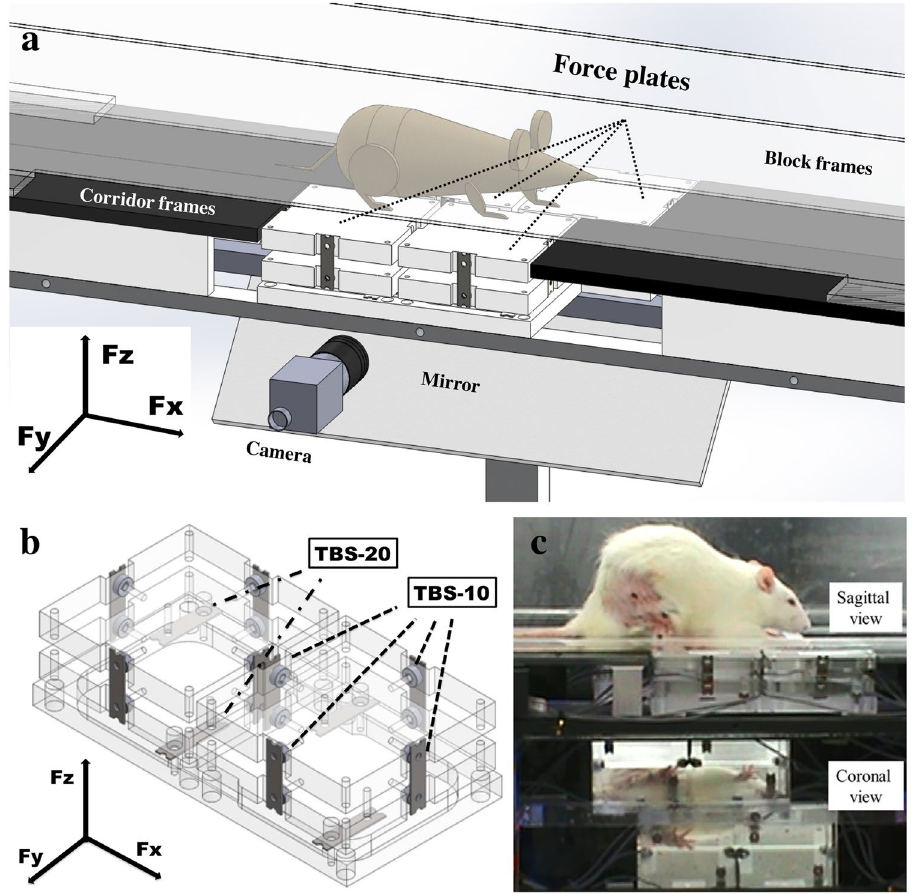
Figure 5. The system consisted of four force-sensor units, four corridor frames (black acrylic plates), two transparent block frames, a 45° mirror, and a CCD digital camera with the GigE interface. The force-sensor units could be easily placed in the corridor frames in combination for various tasks (usually in the center of the corridor). The two transparent block frames were adjustable to guide the rats to make a straight walk ( a ). Every force-sensor unit was composed of two acrylic plates mounted with four TBS-10 beam force sensors to measure Fx and Fy, and one steel frame mounted with two TBS-20 beam force sensors to measure Fz. The recorded maximum vertical force, Fz, which corresponded with each isolated footprint of each limb on one acrylic plate, was defined as the DWB. Meanwhile, the recorded Fx and Fy were defined as the forward (negative value)/ backward (positive value) shearing force and outward (positive value)/inward (negative value) shearing force, respectively ( b ). Using this customized setup and the 45° mirror that reveals the bottom-up images, the contact points of all four limbs during walking were clearly recorded in the sagittal and coronal planes ( c